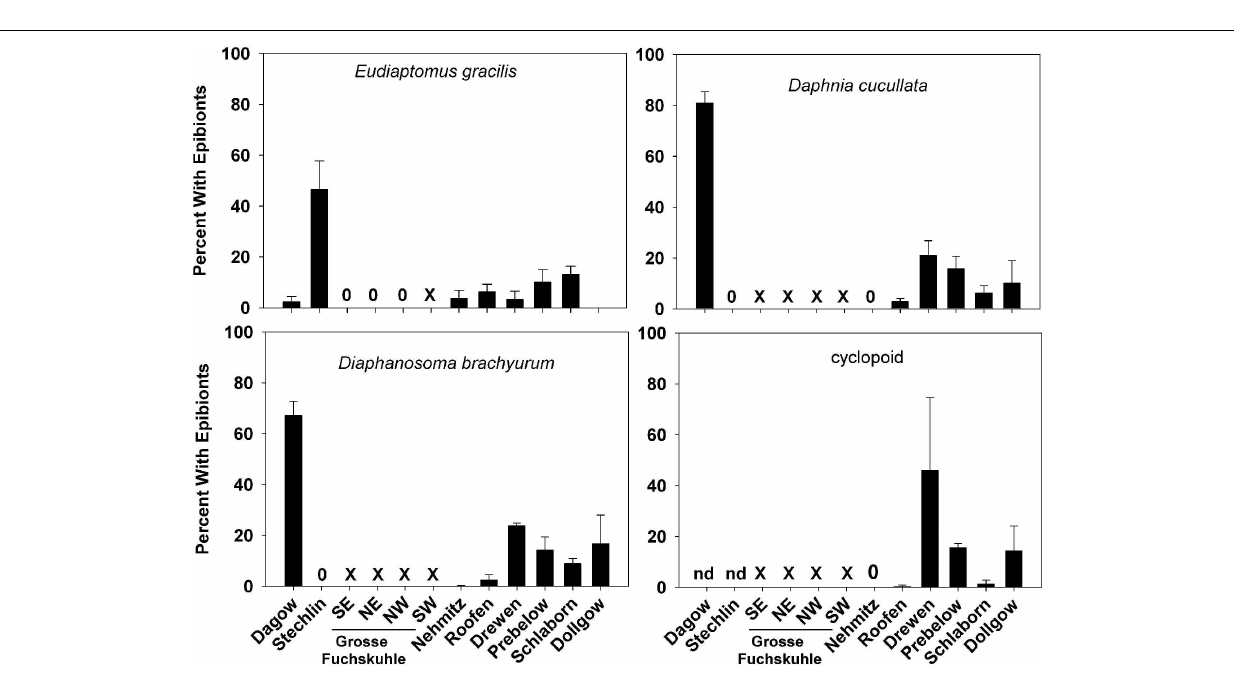
Diaphanosoma brachyurum , and Cyclopoid copepods in each lake. 0 = no epibionts were found on that zooplankton group, X = zooplankton group was not present in that lake, nd = no data.